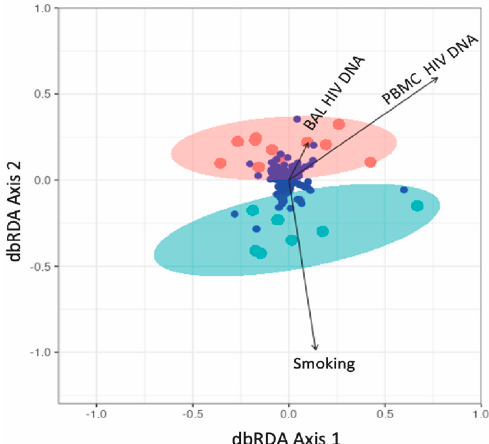
Figure 8. Distance-based redundancy analysis (dbRDA) on the lung bacterial community composition with explanatory variables of smoking and HIV-DNA levels (sample size = 18). Hellinger-transformed community data was ordinated as circles of either pink (nonsmoker) or cyan (smoker) and bacterial ASVs were presented as the small blue circles. The arrows represent the influence of constraining variables on bacterial communities where a small angle between two arrows indicated a similar influence of the two constraints on community composition.